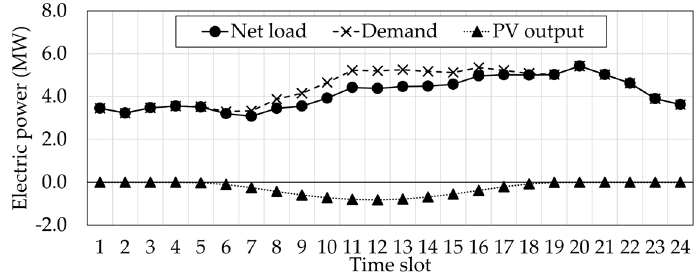
Figure 3. Profiles of net load, electrical load, and aggregated PV output.